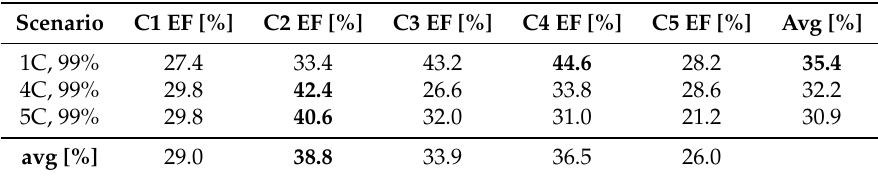
Table 8. Efficiency factors (EFs) for all couplings, depending on the number of solenoids, for duty cycle equal to 99%. Average values (avg) of columns and rows are